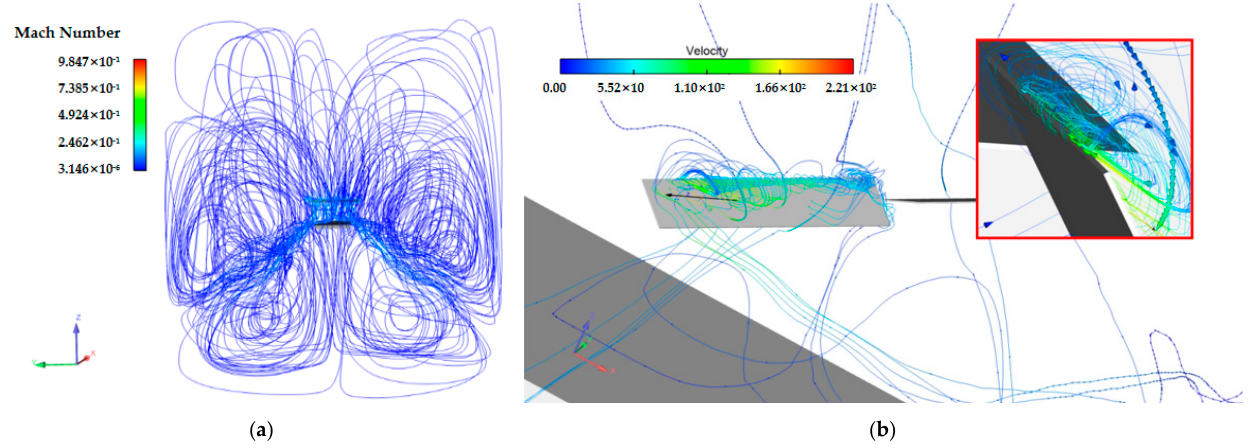
Figure 5. Mach Number streamline ( a ) and velocity streamline ( b ) of case 1.